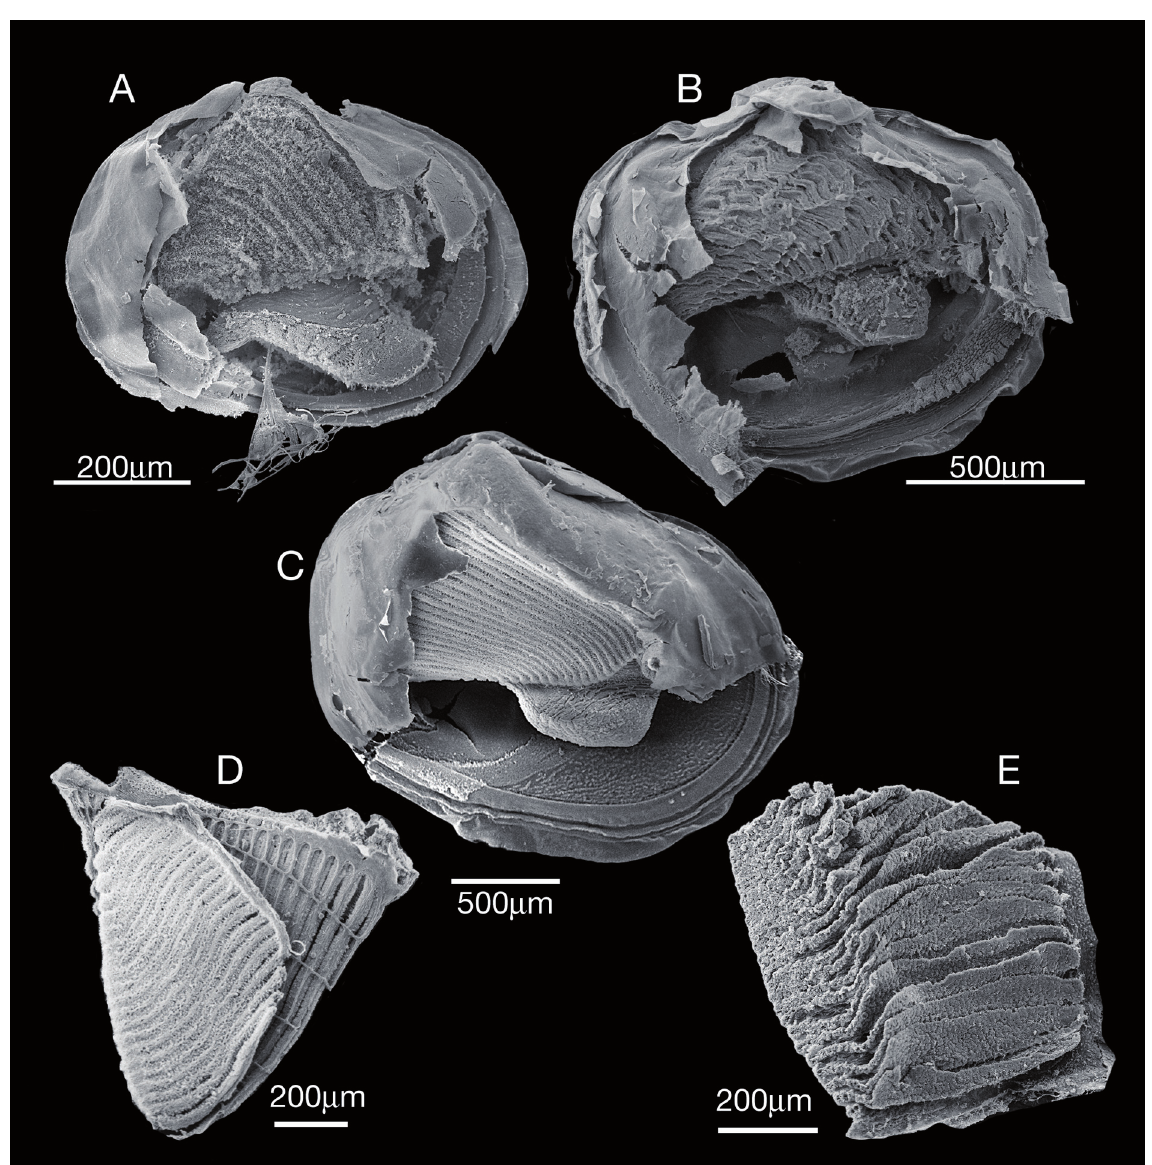
Fig. 4. Scanning electron micrographs of anatomy. A . K. symmetros (Jeffreys, 1876) from Biscay. B . Syssitomya pourtalesiana sp. nov. from Norwegian Sea. C . Montacuta substriata (Montagu, 1808) from North Sea. D . Excised ctenidium of M. substriata . E . Excised piece of ctenidium from S. pourtalesiana sp.